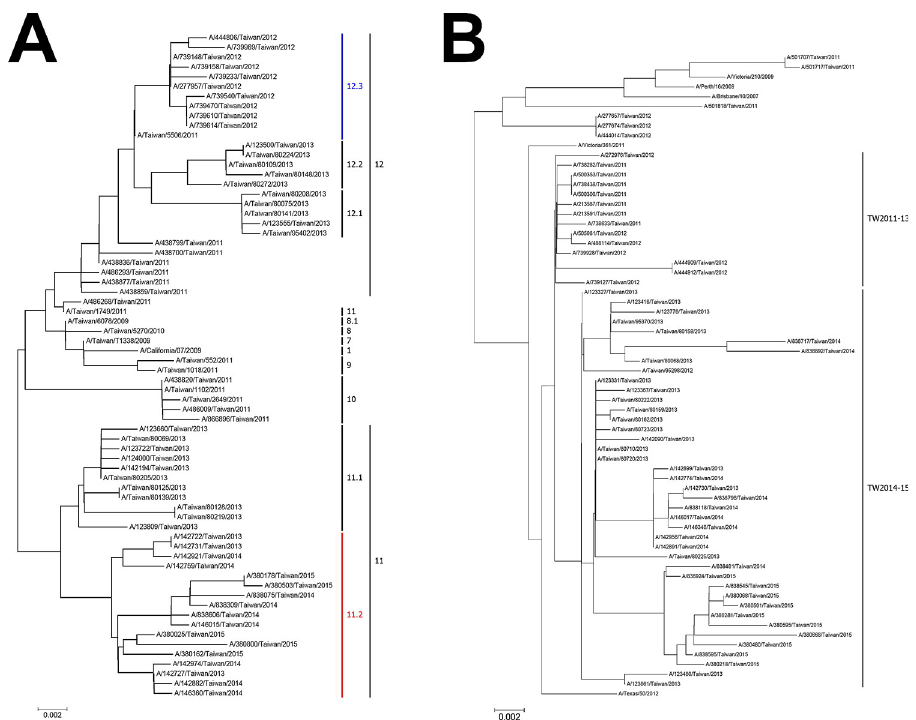
Fig 4. Phylogenetic relationships of the full-length hemagglutinin gene. A phylogenetic tree was constructed using the neighbor-joining method and MEGA software. Tree reliability was evaluated using 1,000 bootstrap replicates, and bootstrap support values greater than 75 are shown. A. Phylogenetic tree of Influenza A pdm H1N1 HA gene sequences. Clades 11.2 and 12.3 were differentiated from clades 11 and 12 in samples collected between 2011 to 2015. The new clade 12.3 was differentiated from clade 12 using samples collected between 2011 and 2012, and the new clade 11.2 was differentiated from clade 11 in samples from 2013 to 2015 in Eastern Taiwan. B. Phylogenetic tree of Influenza A virus H3N2 HA gene sequences. The new clade TW2014–2015 was differentiated from clade TW2012– 2013 using samples from 2014 to